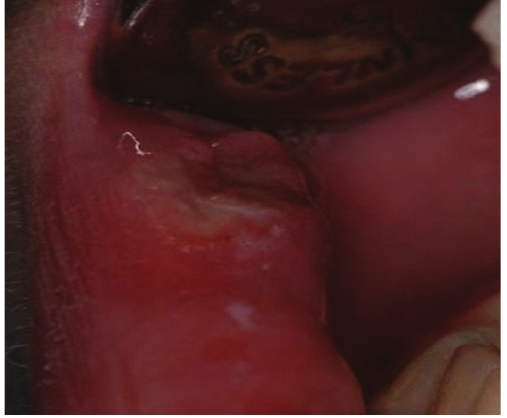
Figure 3: Ulceration of lower